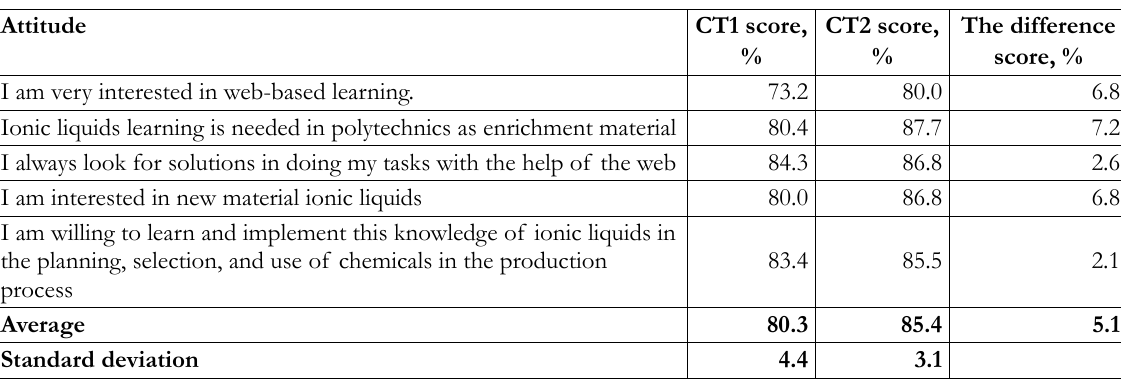
Table 3. The scores of